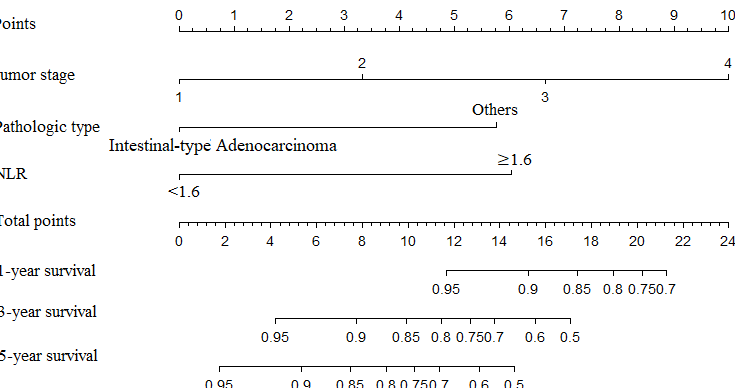
Figure 1. Nomogram included tumor stage, pathological type, and neutrophil to lymphocyte ratio (NLR) by the primary cohort, which were used for the prediction of the 1-, 3-, and 5-year overall survival (OS) in the GC patients.